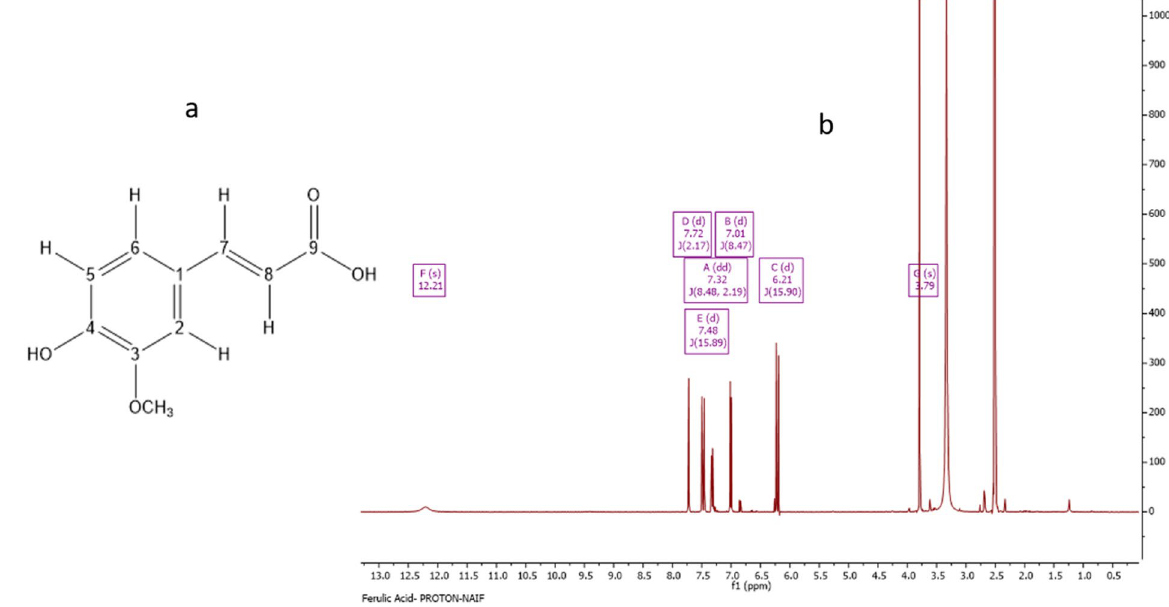
Figure 4. Characterization of S-6-13 as ferulic acid. ( a ) Structure of ferulic acid; ( b ) 1 H NMR spectrum (400 MHz) of ferulic acid (S-6-13).